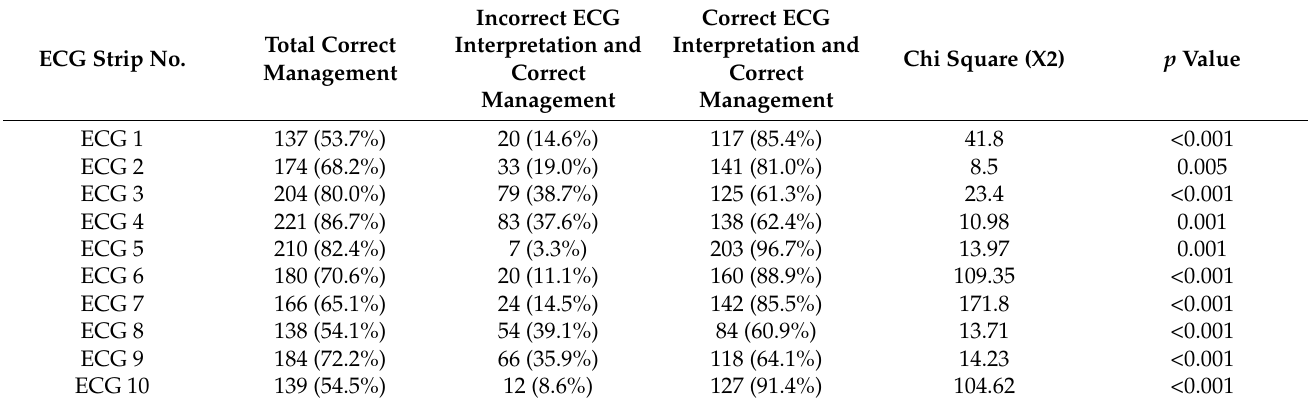
Table 5. Relationship between participants’ ECG interpretation knowledge and arrhythmias